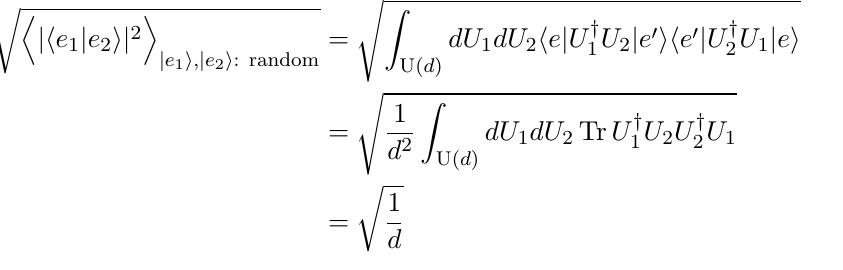
Figure 12 . The maximized overlap averaged over the realizations of random coupling J q(cid:10) 2 (cid:11) B 0 (+) . Here the horizontal axis is (cid:22) ( ; ; ; ) j J ijk‘ j (cid:12) h ij # # (cid:1)(cid:1)(cid:1) #